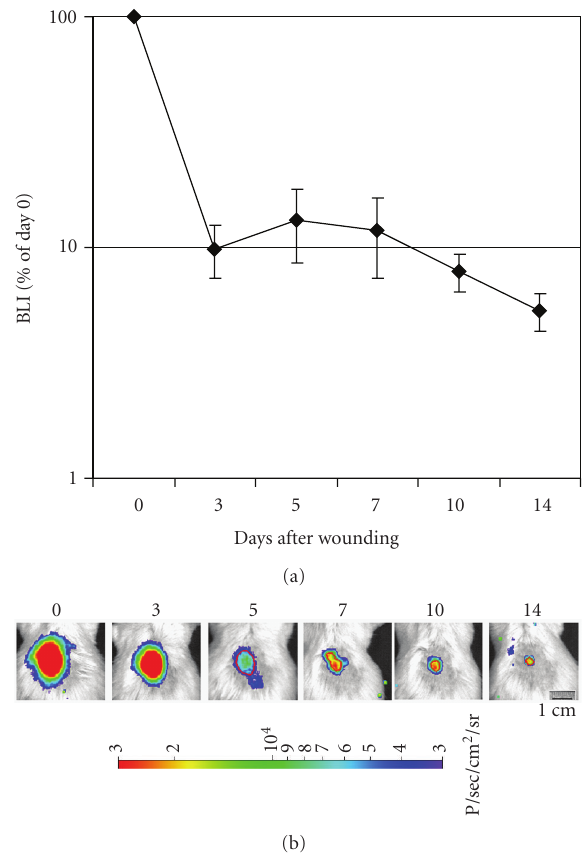
Figure 7: Persistence and engraftment of AT-SCs expressing luciferase after topical administration at the wound. Diabetic mice were treated after wounding with AT-SCs isolated from luciferase-expressing mice. Longitudinal analysis performed by BLI at di ff erent time points after the treatment indicates persistence of signal throughout the process of wound healing. Representative images from an experimental animal at di ff erent time points ( n = 6). Data are indicated as the percentage of the value immediately after topical administration of the cells (day 0). Values are expressed as mean ± SEM indicated by error bars.